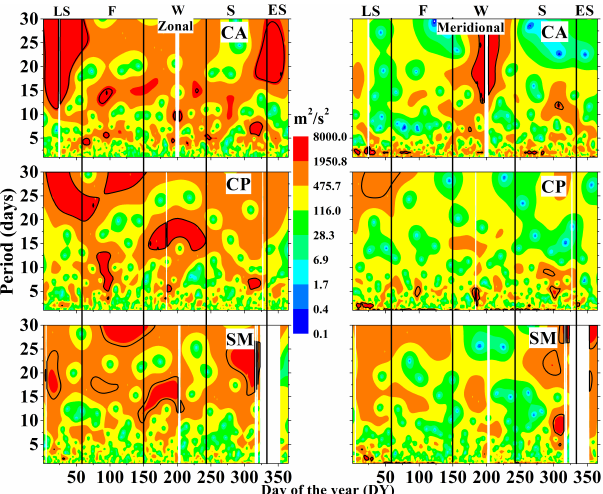
Figure 1. Wavelet power spectra estimated at 90km using meteor radar zonal and meridional winds at CA, CP, and SM. The bold curves represent 95% confidence level. The seasons, i.e., late sum- mer (LS), fall (F), winter (W), spring (S), early summer (ES) are separated by vertical